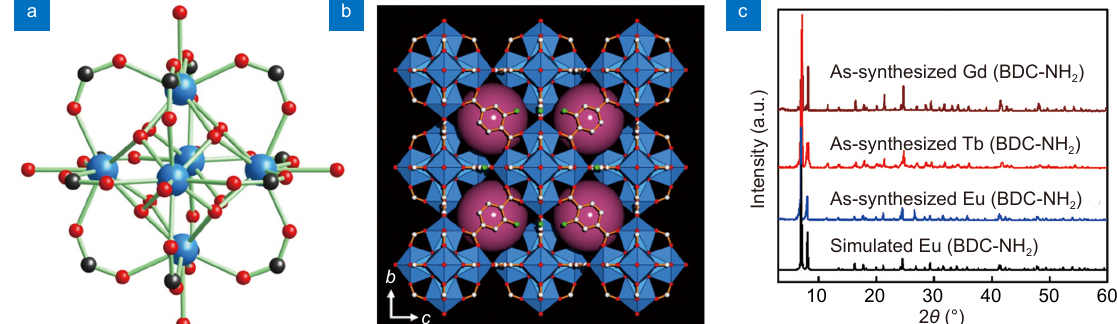
Fig. 1 | ( a ) Structure of 12-connected hexanuclear Eu cluster [Eu 6 ( μ 3 -OH) 8 (CO 2 ) 12 ]. Eu, blue; C, black; O, red. ( b ) Crystal structure of Eu(BDC- NH 2 ) viewed along the a axis. Eu, blue polyhedra; C, gray; O, red; N, blue; H atoms, Me 2 NH 2 cations and free DMF molecules are omitted for clarity. ( c ) Powder X-ray diffraction patterns of Eu(BDC-NH 2 ), Tb(BDC-NH 2 ) and Gd(BDC-NH 2